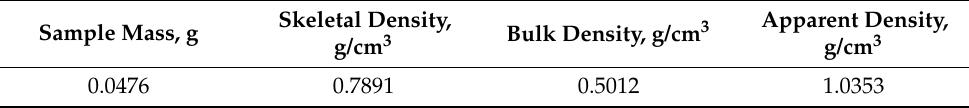
Table 1. Skeletal, bulk, and apparent densities, and mass of PDLG 7502 porous cylinders. Sample Mass, g